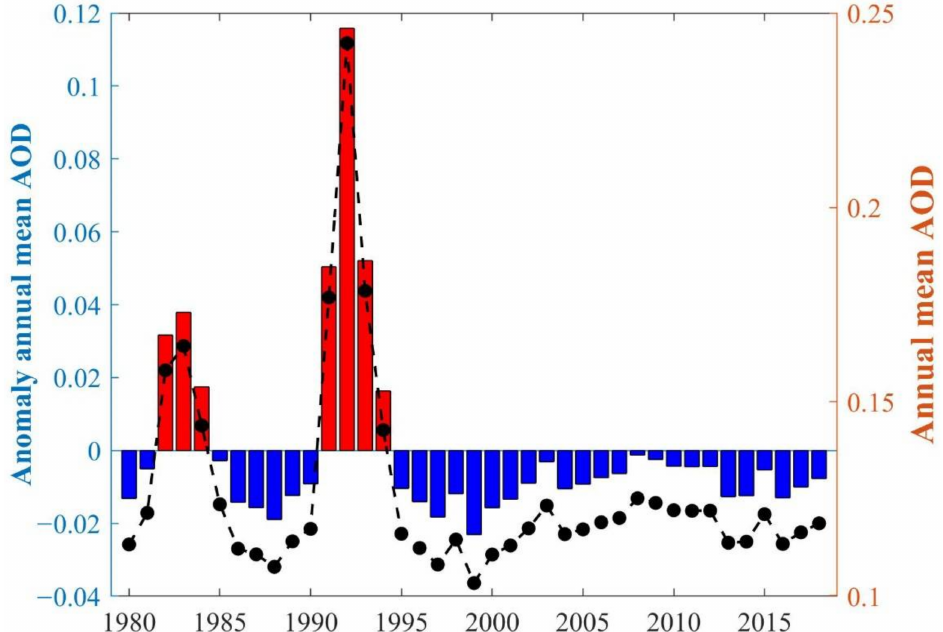
Figure 1. The annual variation of AOD values over the world during 1980–2018. The black line with black makers represents the annual mean AOD values, while the histogram represents the anomaly annual mean AOD